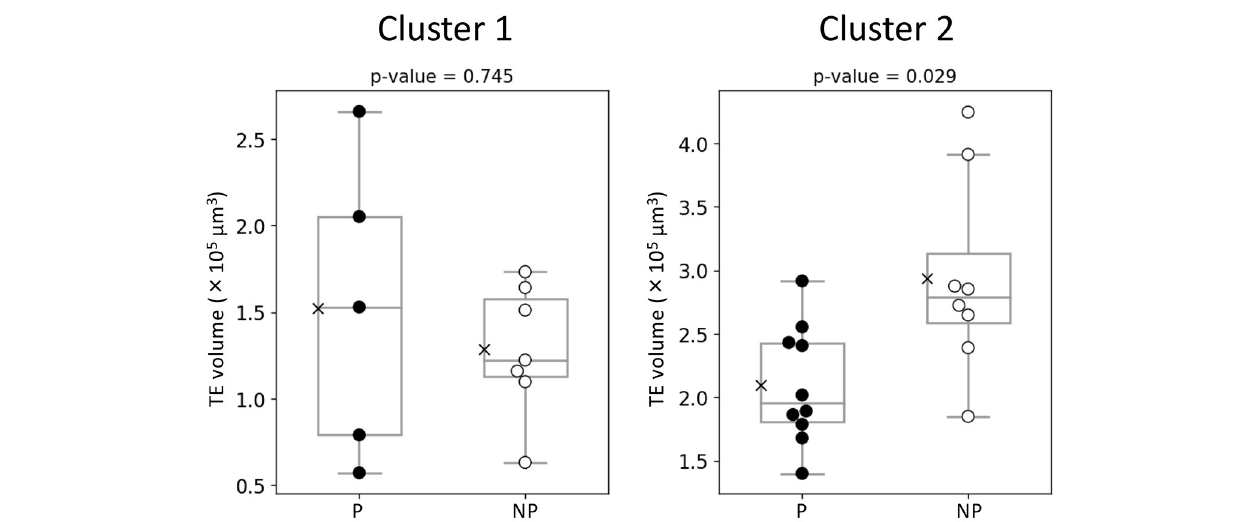
FIGURE 13 | Comparison of TE volume evaluated from the optical coherence tomography (OCT)-scanned 3D images of bovine blastocysts between pregnancy (P) and non-pregnancy (NP) in each cluster (pregnancy: n = 15, non-pregnancy: n = 15). Statistical significance was analyzed using the Mann-Whitney U test. A value of p < 0.05 was considered statistically